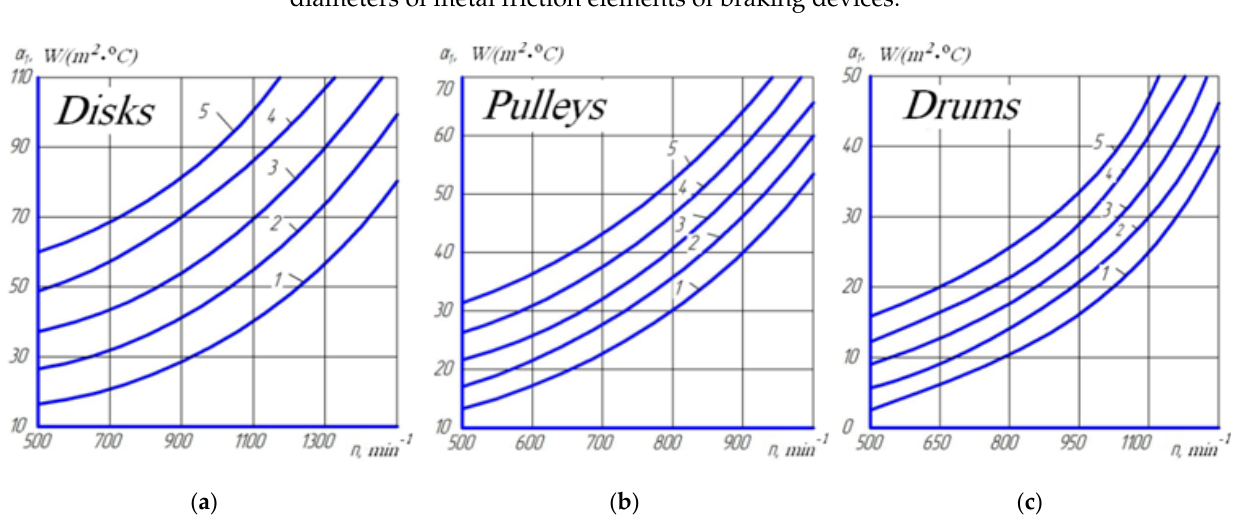
Figure 5. Change in the heat transfer coefficient α i of metal friction elements from the rotational speed n for: ( a ) brake discs: curve 1 − D = 0.2 m, curve 2 − D = 0.3 m, curve 3 − D = 0.4 m, curve 4 − D = 0.5 m, curve 5 − D = 0.6 m; ( b ) brake pulleys: curve 1 − D = 0.8 m, curve 2 − D = 1.0 m, curve 3 − D = 1.2 m, curve 4 − D = 1.4 m, curve 5 − D = 1.6 m; ( c ) brake drums: curve 1 − D = 0.2 m, curve 2 − D = 0.3 m, curve 3 − D = 0.4 m, curve 4 − D = 0.5 m, curve 5 − D = 0.6 m. D is the diameter of a given